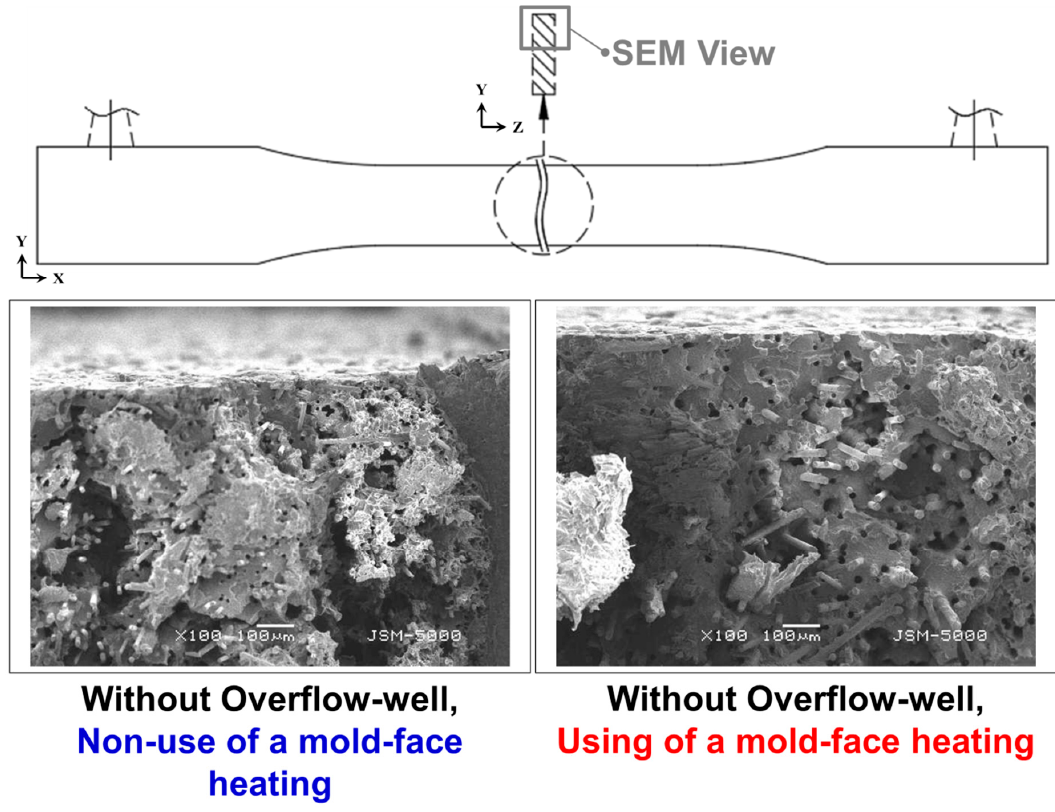
Figure 5. Scanning Electron Microscope (SEM) images of samples with and without the use of mold-face heating.